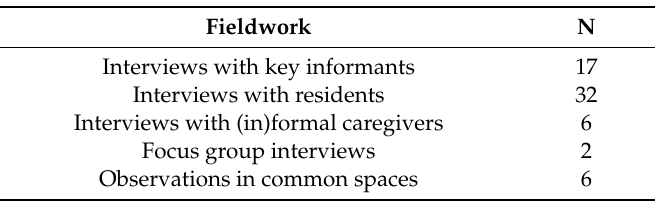
Table 2. Overview of the